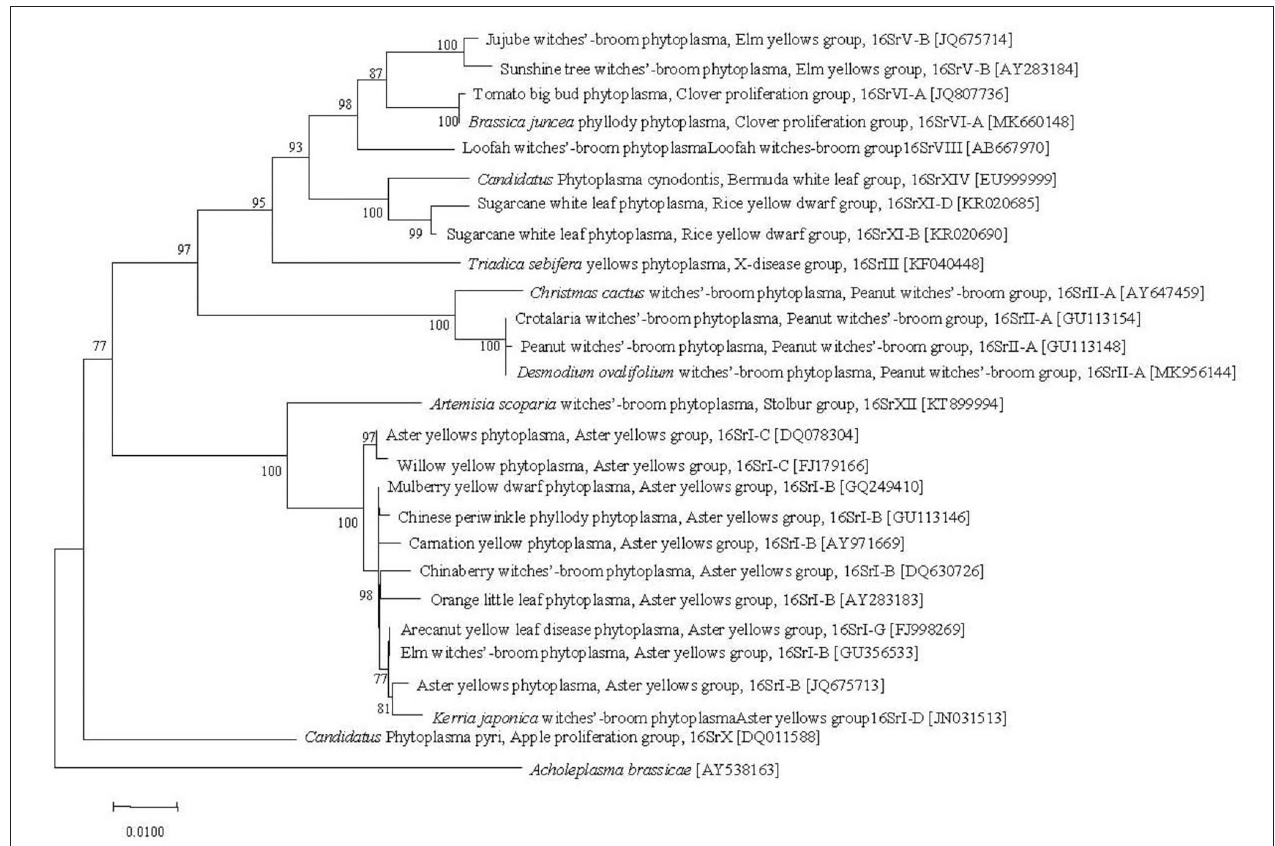
FIGURE 2 | Phylogenetic tree constructed with 16S rDNA sequences of main phytoplasmas in China. Numbers at each node are the bootstrap values of the Neighbor-Joining tree (1,000 replications). The homologous sequence of Acholeplasma brassicae was used as the